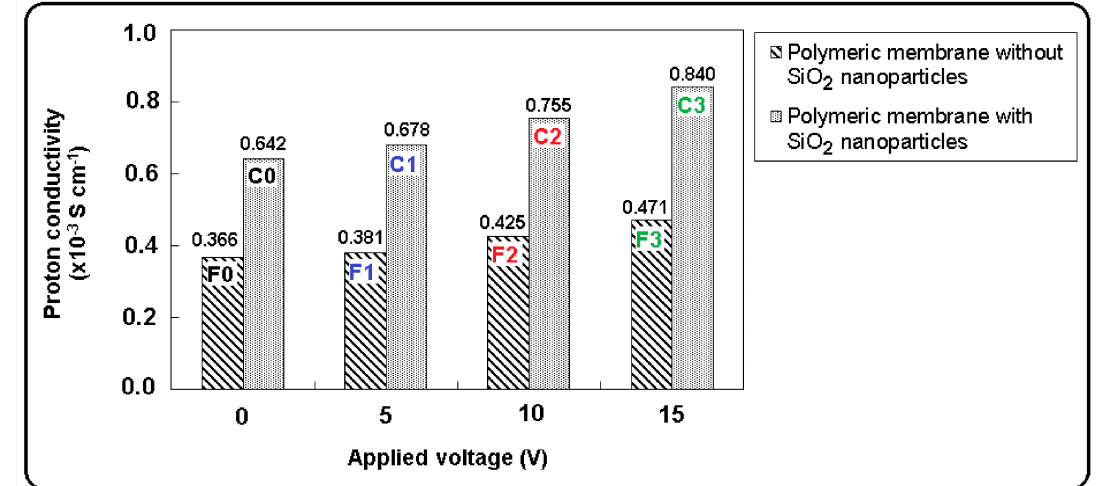
Figure 9. Proton conductivity values of polymeric membranes without and with SiO 2 nanoparticles, before and after used in the electrodialysis